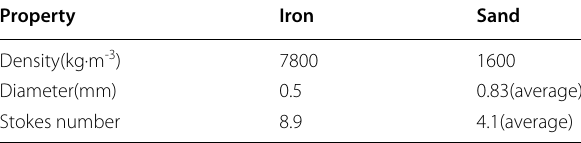
Table 3 Stokes numbers of iron particles and sand particles